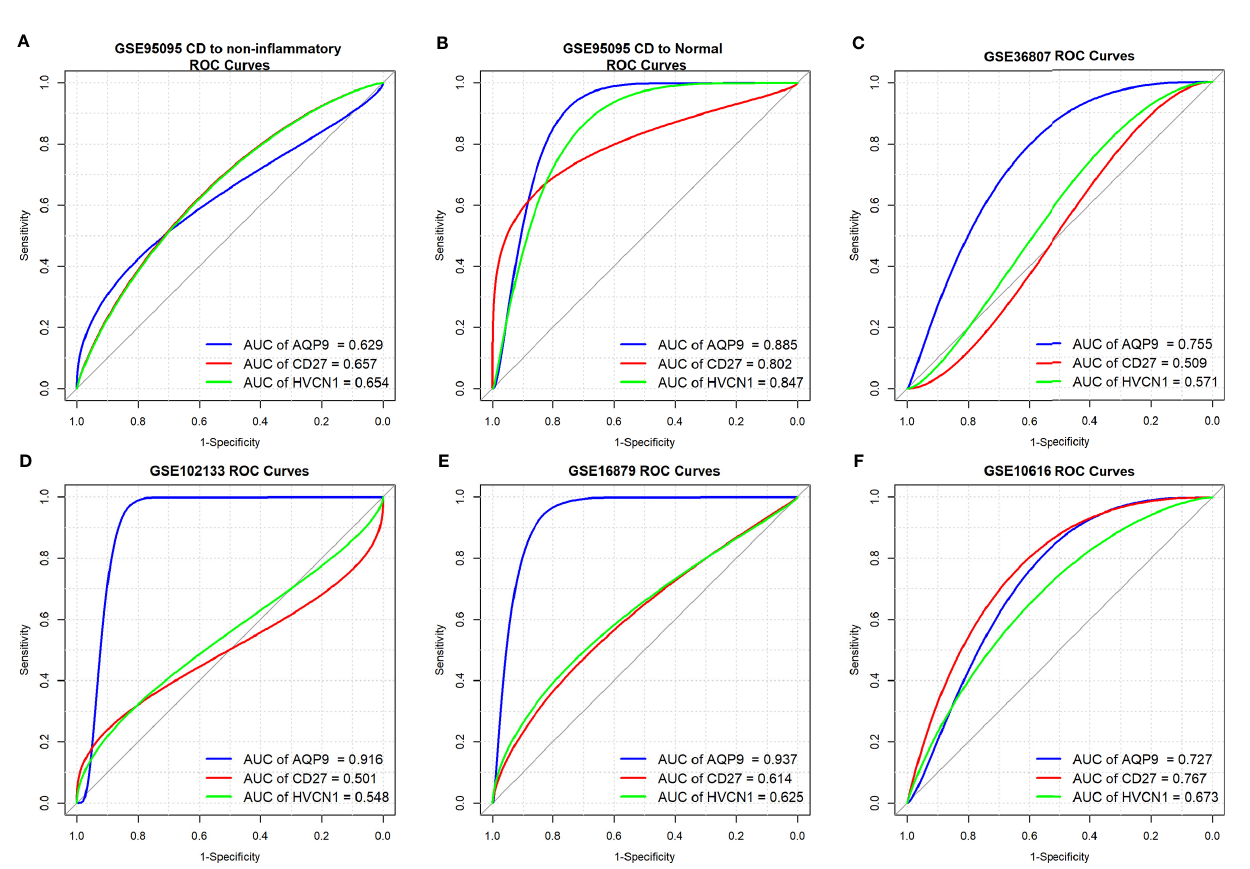
FIGURE 3 | Diagnostic values of AQP9 , CD27 and HVCN1 in CD. (A) Diagnostic value of AQP9 , CD27 , HVCN1 in CD using non-in fl ammatory tissues as controls (GSE95095 dataset); (B) Diagnostic value of AQP9 , CD27 , HVCN1 in CD using normal intestinal tissues as controls (GSE95095 dataset); (C) Diagnostic value of AQP9 , CD27 , HVCN1 in CD (GSE36807 dataset); (D) Diagnostic value of AQP9 , CD27 , HVCN1 in CD (GSE102133 dataset); (E) Diagnostic value of AQP9 , CD27 , HVCN1 in CD (GSE16879 dataset); (F) Diagnostic value of AQP9 , CD27 , HVCN1 in CD (GSE10616